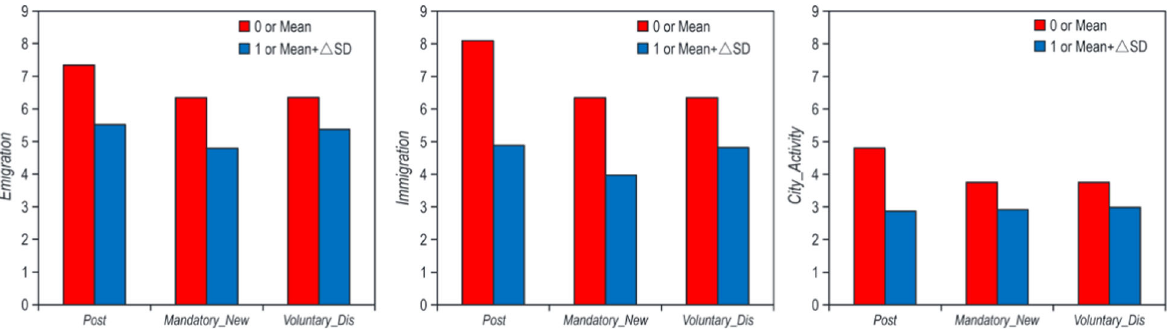
Fig. 6 Impact of government disclosure on behaviors of the susceptible — mobility among the susceptible. Post is an indicator that equals 1 after a province entered the Category I public health emergency regime and 0 before. Mandatory_New is the daily new con fi rmed cases for a province. Voluntary_Dis is the number of independent disclosures by a province ’ s Center for Disease Control (CDC). For indicator Post, the red column represents values for emigration/immigration/city activity when Post is 0 and the blue column represents values for emigration/immigration/city activity when Post is 1. For continuous variables Mandatory_New and Voluntary_Dis, the red column represents values for emigration/immigration/city activity when they are at their mean and the blue column represents values for emigration/immigration/city activity when they are at their mean plus one standard deviation.